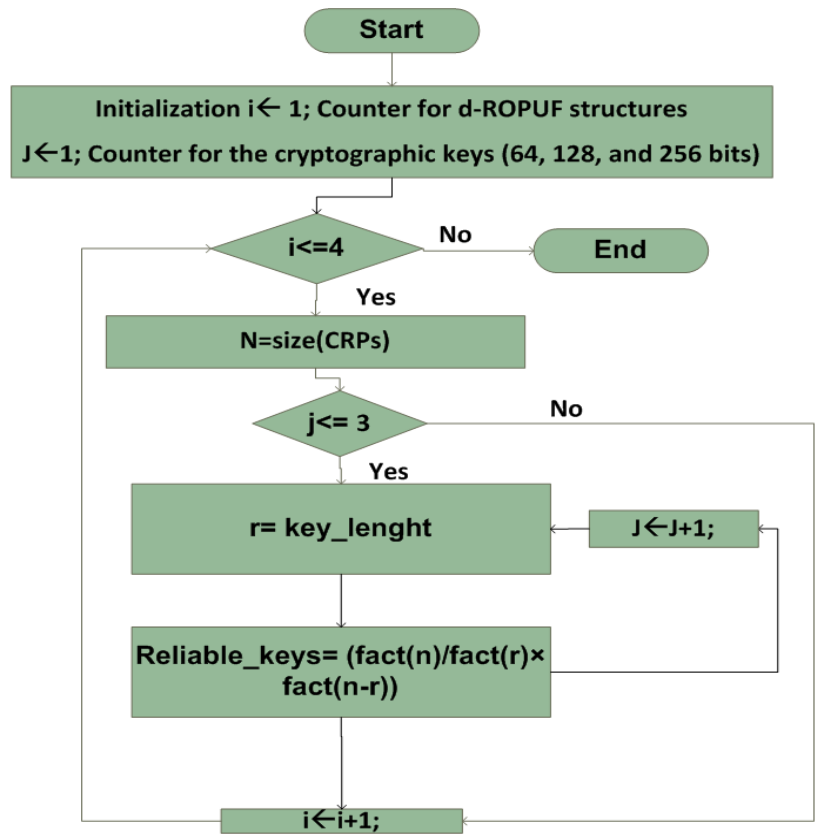
Figure 12. OTD algorithm flowchart: Step